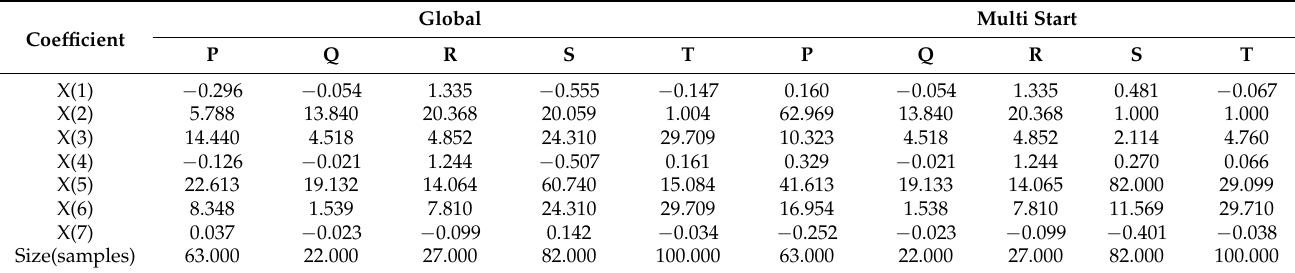
Table A4. Coefficient to fit the model with premature ventricular